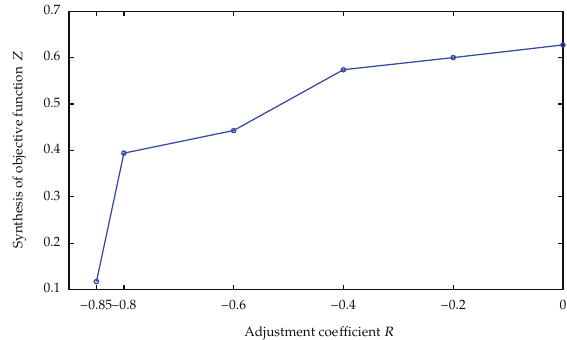
Figure 3: Curve of Z changed with R when operation time is compressed.